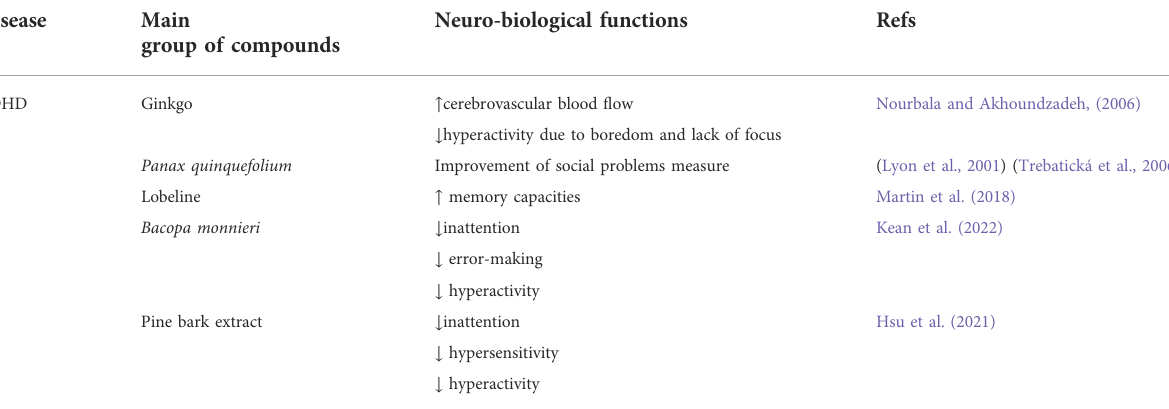
TABLE 6 Bioactive compounds and their mechanism of action used as potential drugs in the treatment of ADHD.